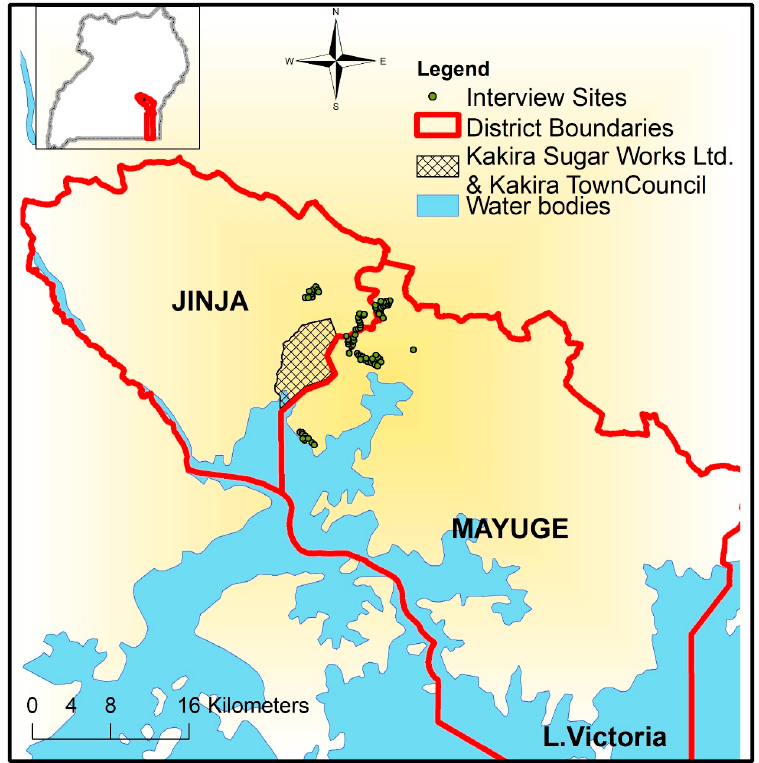
Figure 1. A location map of the study area showing the 120 interview sites ( ● ) within a radius of 21 km from Kakira Sugar Works Limited, Jinja in the commercial sugarcane growing villages of Jinja and Mayuge District, Eastern Uganda.